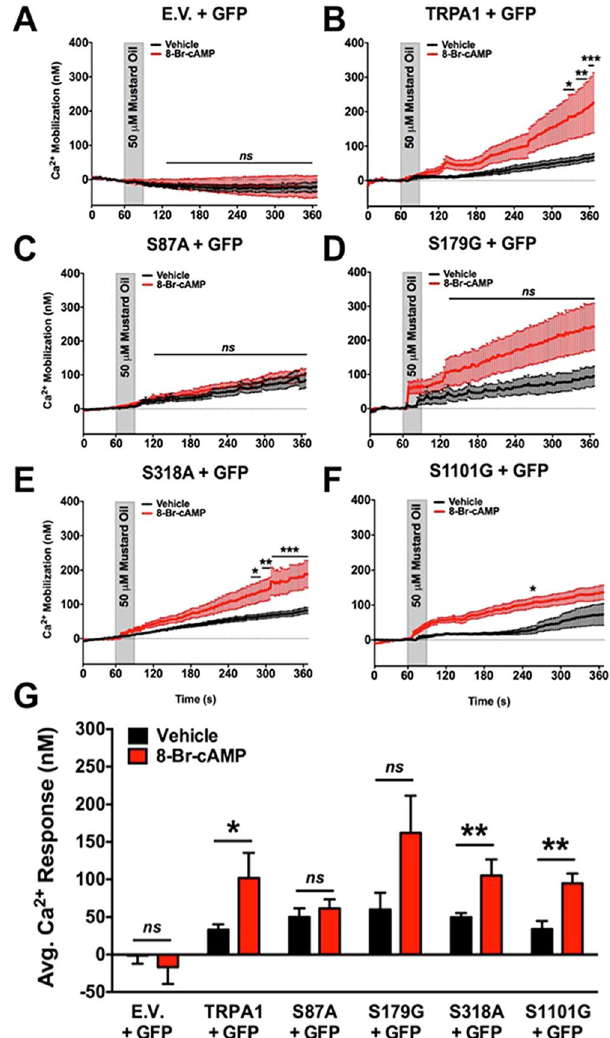
Figure 8. 8-Br-cAMP-sensitization of TRPA1 Requires PKA-phosphorylation Site. Mustard oil (MO, 50 μ M)- activated Ca 2 + mobilization was monitored from DRG sensory neurons harvested from TRPA1 KO mice and transfected with cDNA corresponding to green fluorescent protein (eGFP-N1, GFP) and either pcDNA3 (empty vector, E.V., A ), mouse TRPA1 WT (TRPA1, B ), mouse TRPA1 S87A (S87A, C ), mouse TRPA1 S179G (S179G, D ), mouse TRPA1 S318A (S318A, E ), or mouse TRPA1 S1101G (S1101G, F ). For 5 min prior to recordings, DRG were pre-incubated for 5 min in vehicle (ddH2O) or 8-Br-cAMP (10 μ M), then DRG were challenged with MO (30 sec) and Ca 2 + accumulation was measured. Cumulative traces are displayed in panels A – F , quantitative measurements from multiple neurons displayed in panel G . * p < 0.05; ** p < 0.01; ns = no significance; n = 15–39 MO responsive cells per TRPA1 cDNA transfection; trace significance determined by two-way ANOVA with Bonferroni posthoc analysis and quantified data significance determined by unpaired student’s t